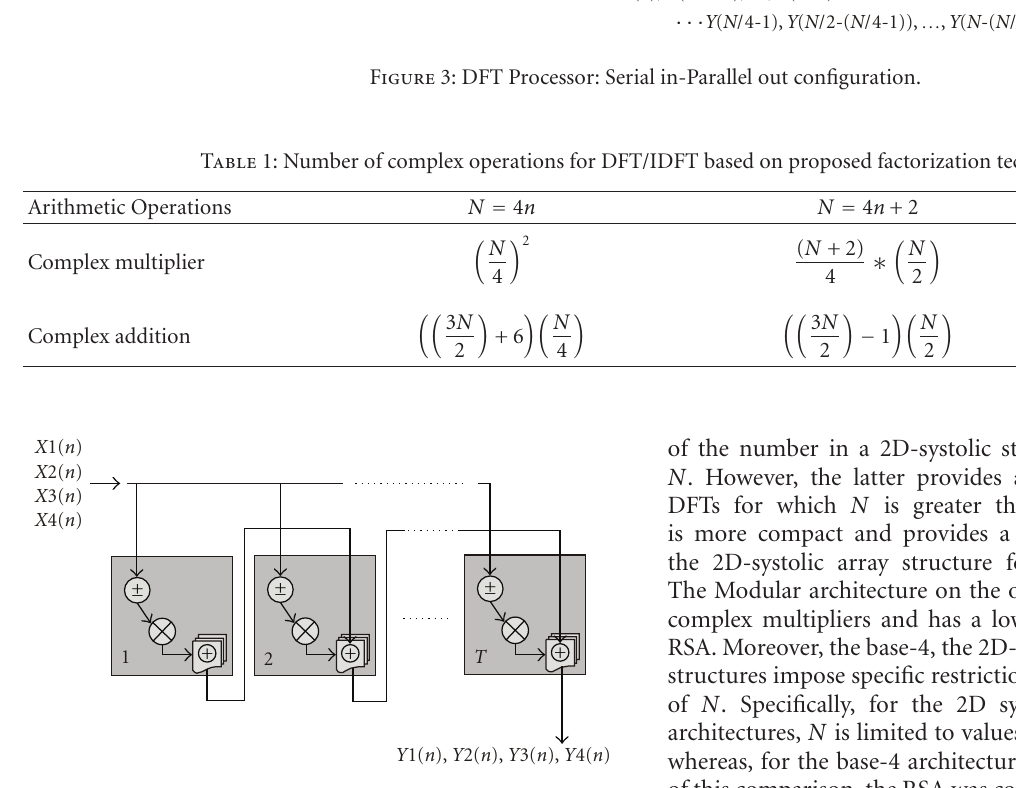
Figure 4: Systolic array architecture for a polyphase filter bank consisted of four T -tap FIR